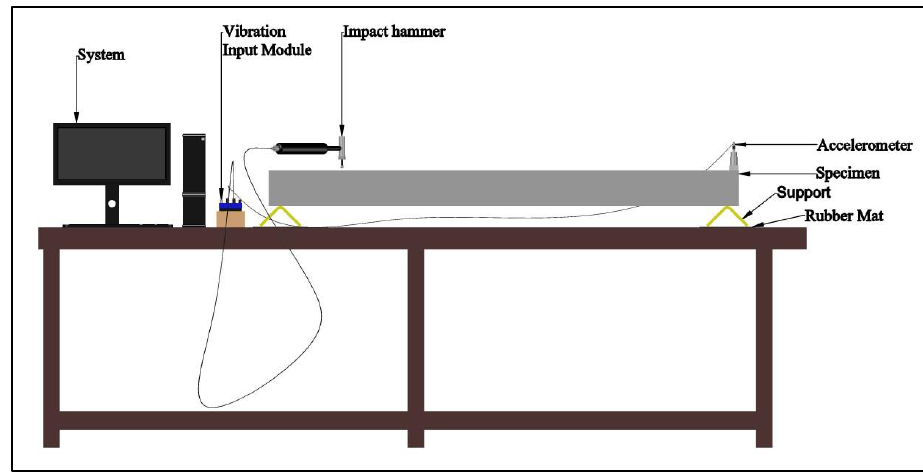
Figure 25. The schematic test arrangement for observing natural frequency.